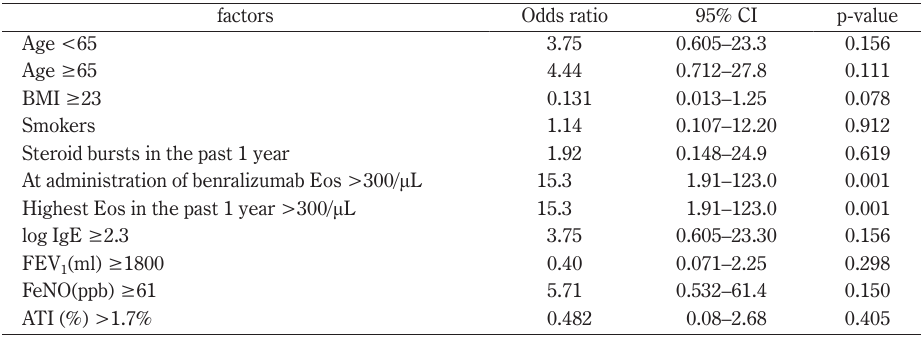
Figure 3 Changes in OCS (mg/d) at 0 W and 16 W Table 2 Characteristics of responders and non-responders at week 16 of treatment with